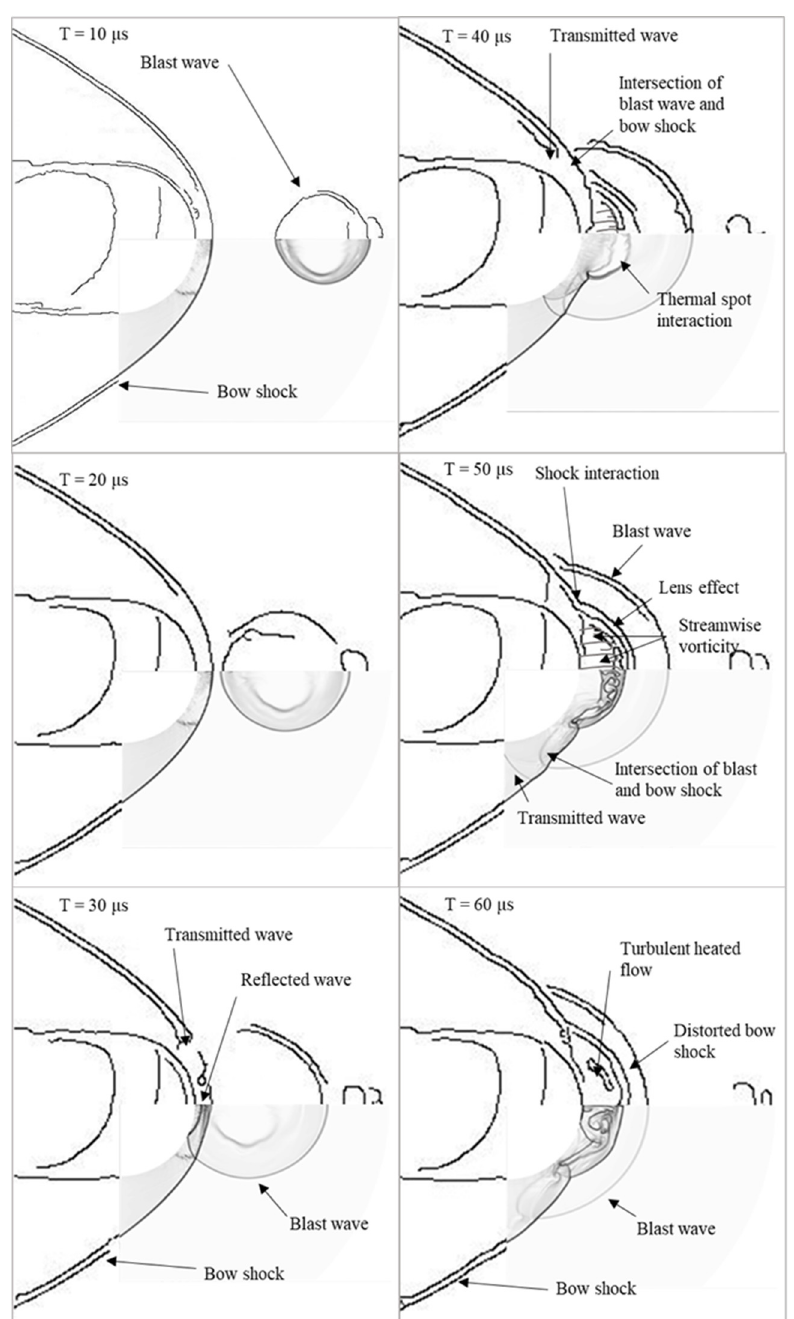
Figure 3. Comparison between the numerical schlieren image and the experiment (single pulse of 283 mJ, the figure is adapted from